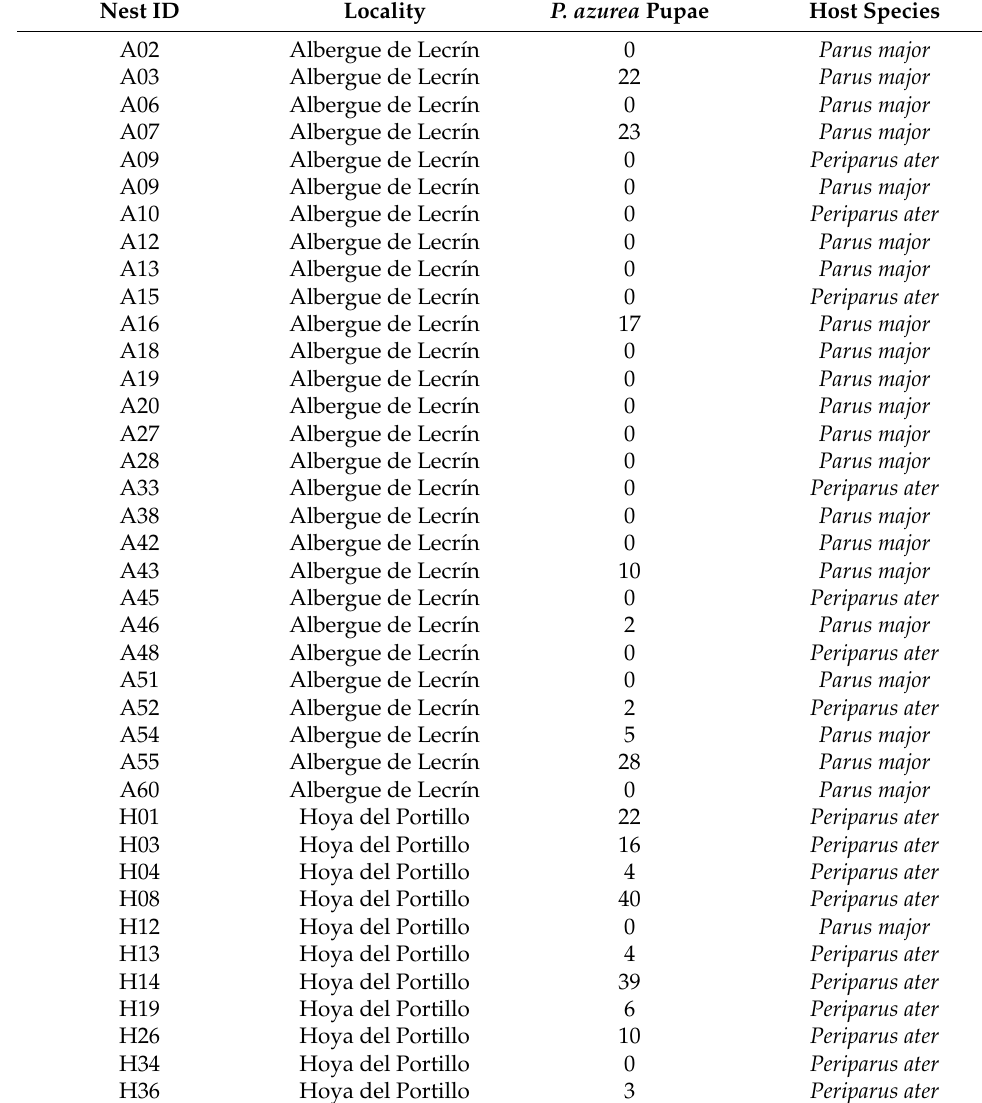
Table A1. Raw data used in the study, indicating nest identification, locality, number of P. azurea pupae found in the nest and host